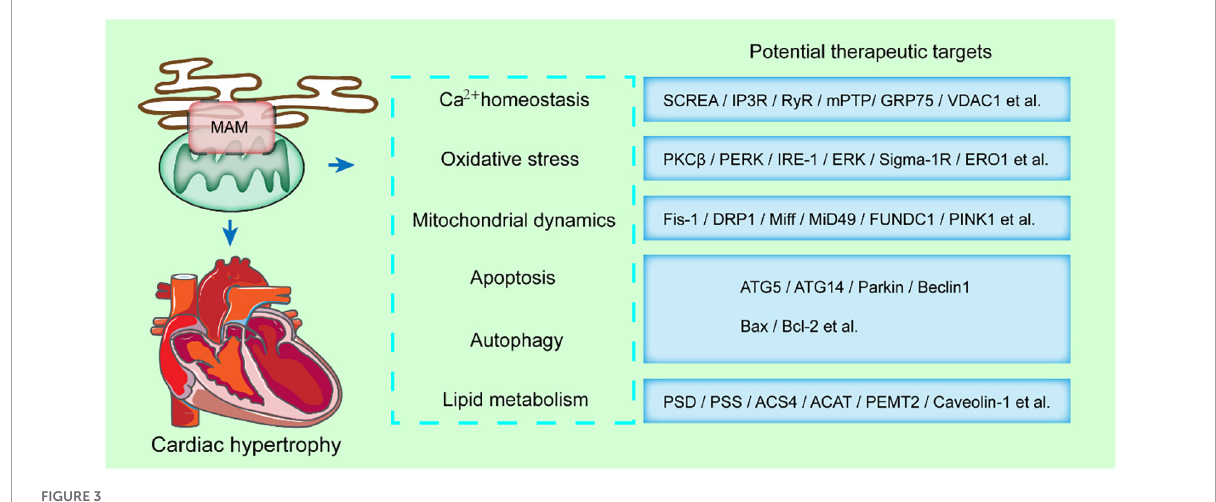
FIGURE3 MAMs-enriched proteins present a potential therapeutic strategy in cardiac hypertrophy. MAMs modulates some key cellular processes, such as calcium homeostasis, oxidative stress, mitochondrial dynamics, apoptosis, autophagy, and lipid metabolism. The MAMs-enriched proteins mediating these processes are potential therapeutic targets in cardiac